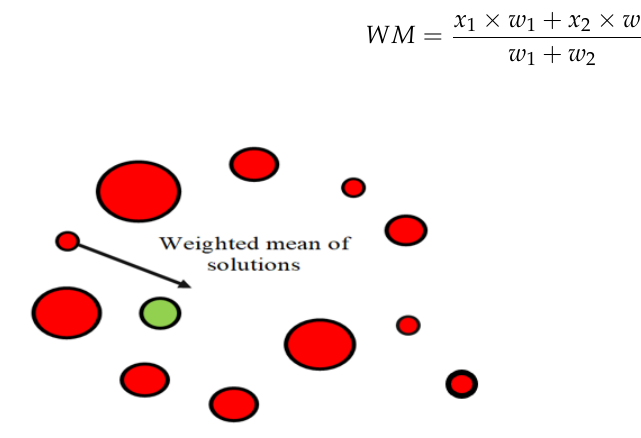
Figure 4. Weighted mean for a set of solutions/vectors.